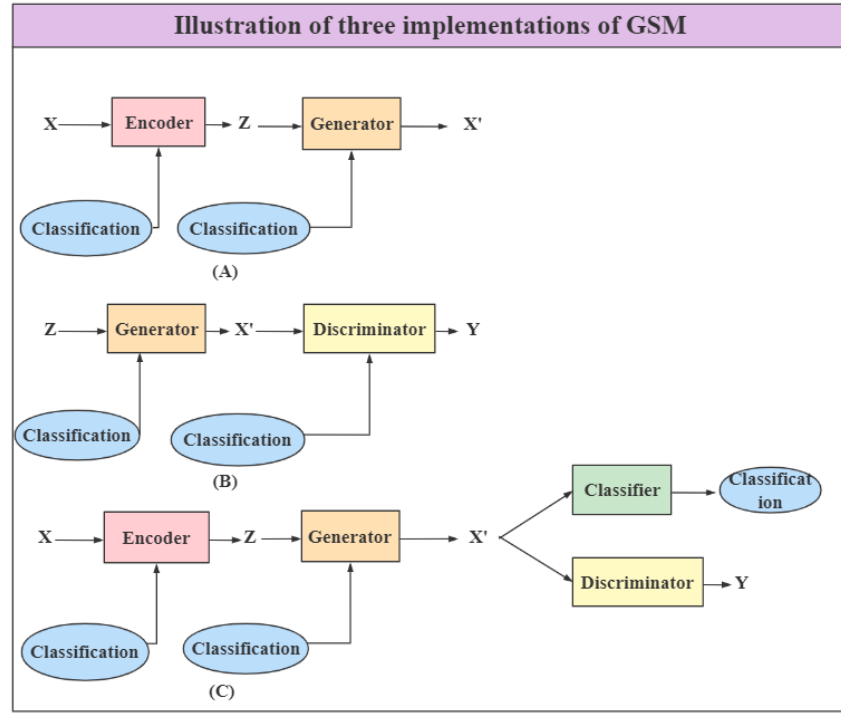
Figure 5. Illustration of generative module on YOLO-v5 structure.